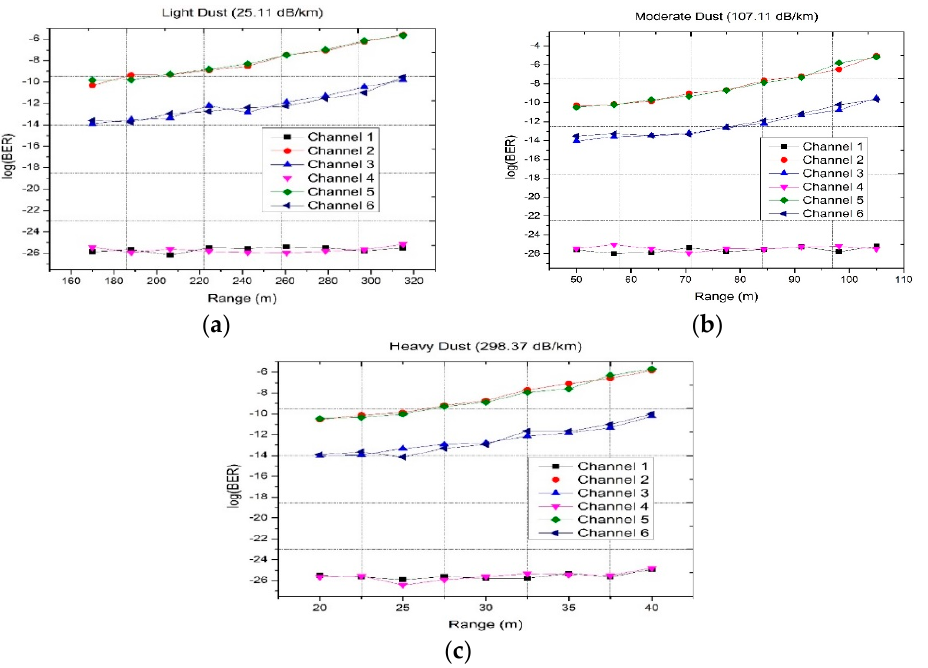
Figure 8. Log (BER) against FSO link for OAM/OCDMA-FSO system under ( a ) LD, ( b ) MD, and ( c ) HD.